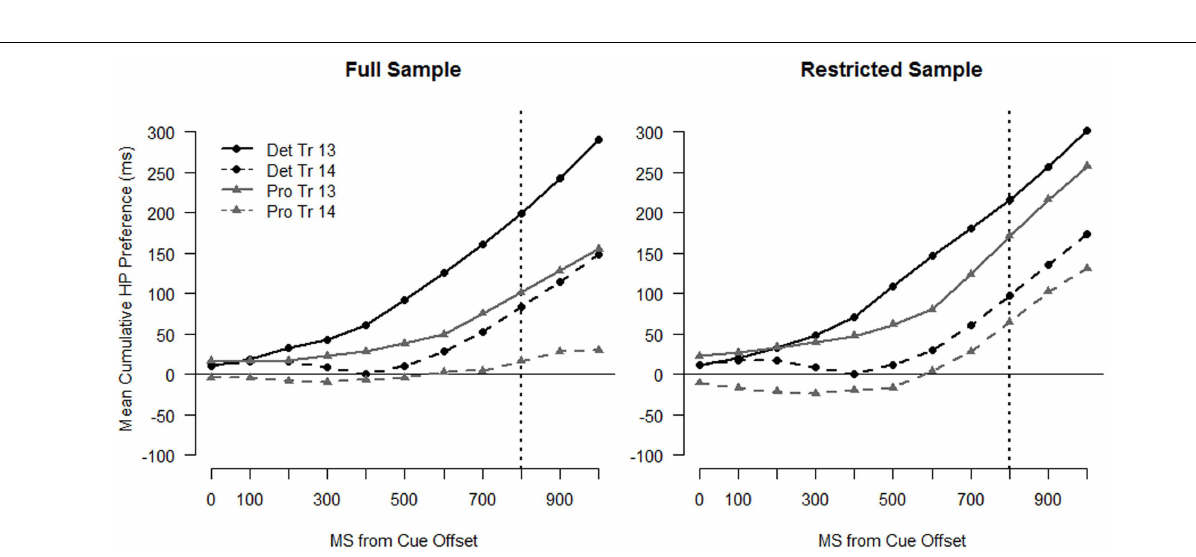
FIGURE 7 | Cumulative preference profiles forTrials 13 and 14. The left panel depicts data from the full sample and the right panel depicts data from the restricted sample. Points above 0 indicate a preference for the HP location and points below 0 indicate a preference for the LP location.The dotted vertical line indicates target